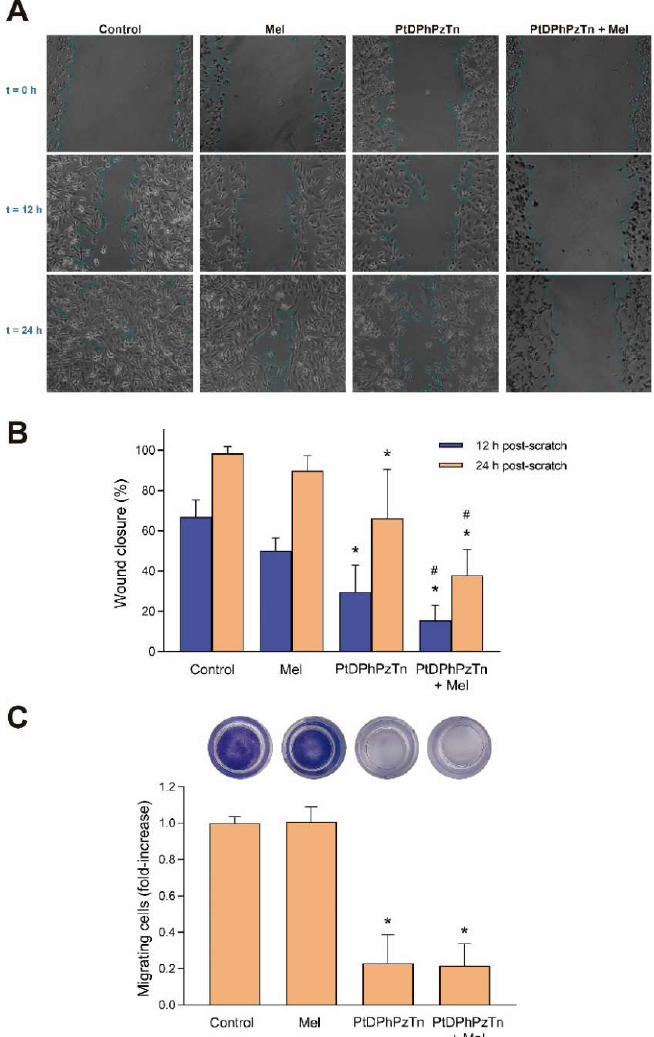
Figure 5. Combinatory treatment of PtDPhPzTn and melatonin altered migration properties of MDA-MB-231 cell line. Cells were treated with 10.4 µM PtDPhPzTn in the presence or absence of 1 mM melatonin (Mel) or the vehicle (DMF/DMSO, control) for 24 h. ( A ) Representative images depicting wound-healing assay in cells challenged with the indicated drugs. ( B ) Histogram bars show the percentage of wound closure after 12 and 24 h, where 100% represents a fully closed wound. Values represent means ± S.D. of 12 independent experiments. ( C ) Proportion of migrating cells after 24 h of exposure to the indicated drugs determined by transwell migration assay (for details, see Section 2.10). Representative images of transwell inserts for each condition are depicted in the upper part. Data represent means ± S.D. of 5 independent experiments and are expressed as fold-increase of control values. * p < 0.05 compared to its corresponding control value (Dunnett’s test). # p < 0.05 compared to its corresponding PtDPhPzTn value (Tukey’s test).